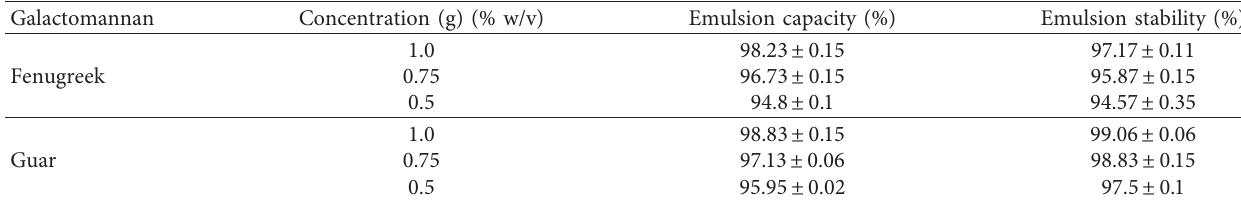
Table 2: Emulsion capacity and stability of fenugreek galactomannan and guar galactomannan.